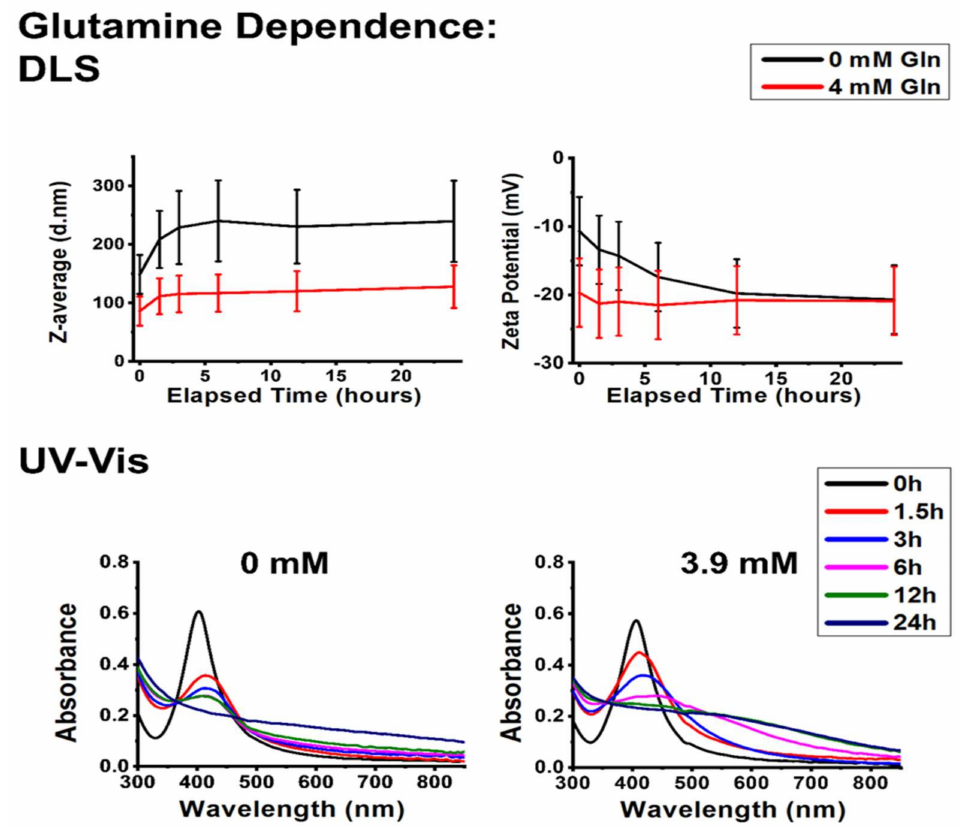
Figure 6. The presence of glutamine affects the stability of polyvinyl-pyrrolidone-stabilized sil- ver nanoparticles. The average hydrodynamic diameter (Z-average) and zeta potential values were assessed by dynamic light scattering (DLS) (top) and UV–Vis absorbance spectra (bottom) of AgNP@PVP, recorded over 24 h in the presence of